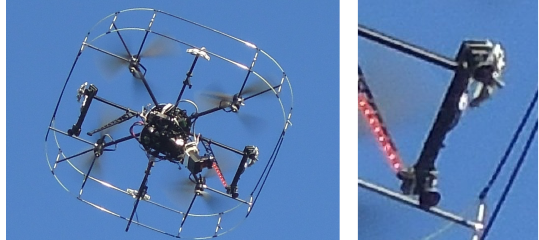
Figure 1: Illustration of the UAV, one stereo pair is looking for- ward and one backwards providing a wide field of